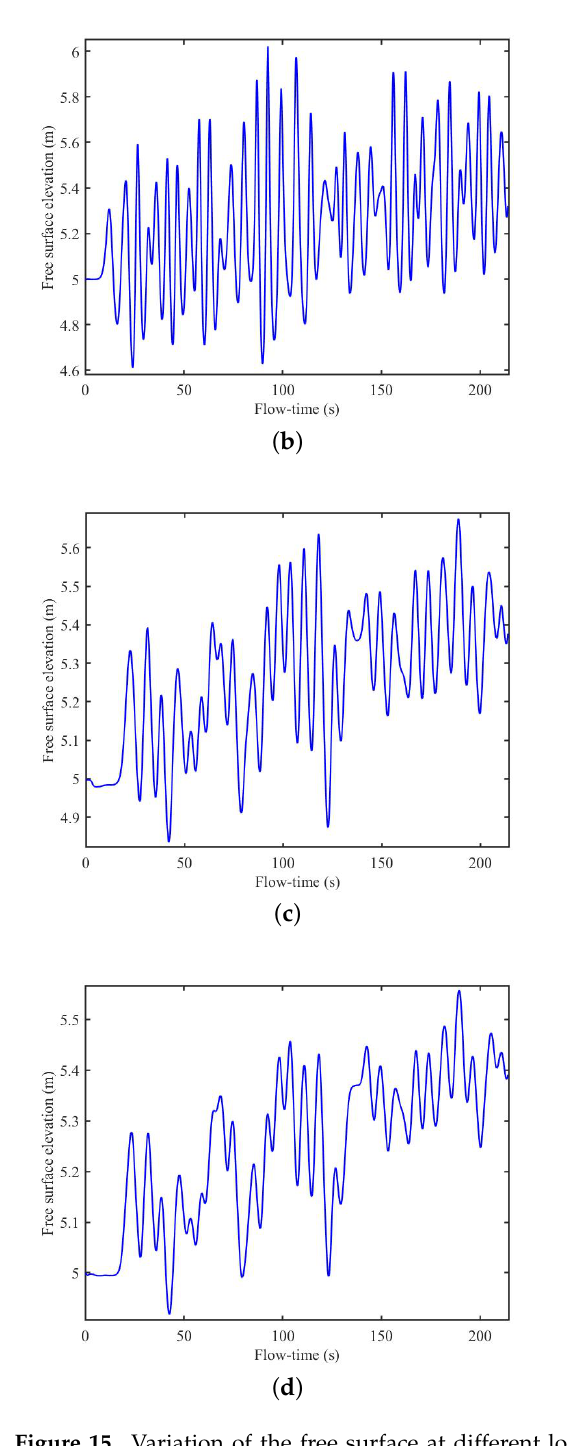
Figure 15. Variation of the free surface at different locations: ( a ) x = 0.5 m, ( b ) x = 72.025 m, ( c ) x = 143.5 m and ( d ) x = 146.4 m, with H s = 1.88 m and ω p = 0.993